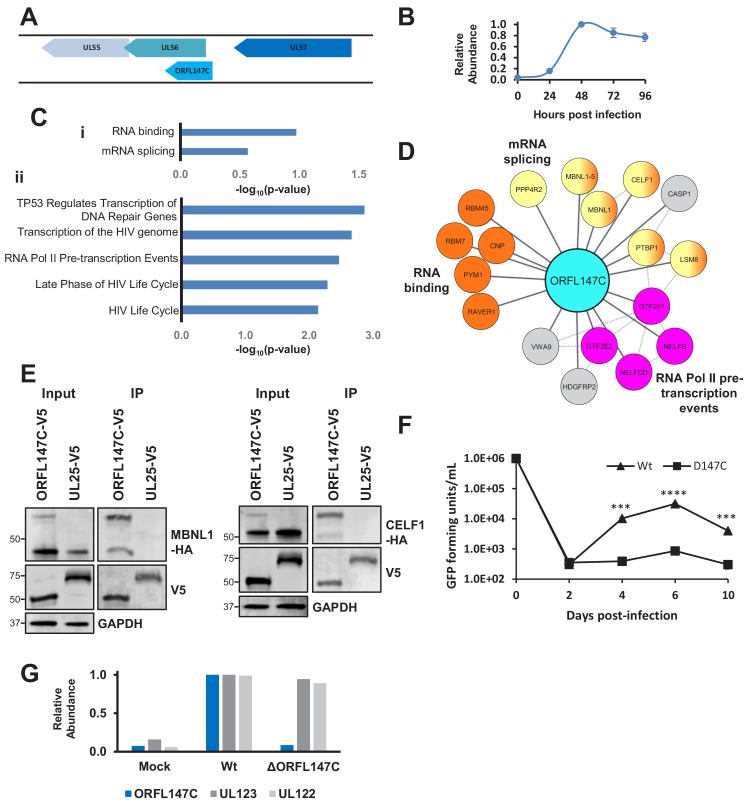
HCMV ORFL147C interactors function in RNA binding, splicing and transcription.(A) Diagram of the ORFL147C coding sequence and relation to neighbouring viral genes. (B) Expression kinetics of ORFL147C, taken from Weekes et al. (2014). Data was taken from experiments WCL2 and WCL3, enabling assessment of 24, 48, 72 and 96 hr time points in biological duplicate. Error bars show range. Mean expression was normalised to a maximum of 1. (C) Enrichment analysis of 80 human HCIPs interacting with ORFL147C. (i) DAVID analysis using all human proteins as background. Benjamini-Hochberg adjusted p-values are shown. (ii) Reactome database analysis (Fabregat et al., 2018) showing results with a minimum of 4 entities per enriched pathway. Full details of interacting proteins are given in Supplementary file 7A-B. (D) A subset of HCIPs for ORFL147C (full data are shown in Figure 6—figure supplement 1). Dashed lines represent human-human interactions derived from Bioplex 2.0 as described in Figure 2, in addition to known interactions that had been experimentally determined or derived from curated data as part of the STRING database. (E) Validation of interaction between ORFL147C and MBNL1 and CELF1 by co-IP, conducted as described in Figure 3. HEK293T cells were transiently transfected with the indicated plasmids, one expressing the C-terminally V5-tagged viral protein and the other expressing C-terminally HA-tagged MBNL1 or CELF1. These proteins were detected with anti-V5 and anti-HA. GAPDH – calnexin loading control. This figure is representative of n = 1 experiment. Expected sizes: MBNL1: 33–42 kDa; CELF1: 50–55 kDa; ORFL147C: 50 kDa; UL25: 74 kDa; GAPDH: 36 kDa. (F) Growth analysis of an ORFL147C-deficient recombinant. The ORFL147C and wild-type viruses were HCMV strain Merlin recombinants in which the enhanced GFP (eGFP) gene was cloned as a 3’-terminal fusion with immediate-early gene UL36, with a self-cleaving P2A peptide releasing the reporter following synthesis. Insertion of GFP does not impede UL36 function in such recombinants (Nightingale et al., 2018). Cells were infected at a MOI of 1, and supernatants harvested and titred every two days. Cells were infected in biological duplicates, and each supernatant was titred in technical duplicates. Mean values are shown, and error bars represent SD. p-values for a difference between wild-type and ORFL147C-deficient virus were estimated using a two-tailed Student’s t-test. ***p<0.001, ****p<0.0001. This figure is representative of n = 2 experiments. All data for this figure are also shown in Figure 6—source data 1. (G) ORFL147C protein is not expressed during infection with the ORFL147C-deficient recombinant (MOI = 2, 48 hr post infection). Viral protein expression was analysed using tandem mass tag-based proteomics as previously described (Nightingale et al., 2018). ORFL147C protein was measured at the same level as during mock infection in cells infected with the ORFL147C-deficient recombinant, attributable to noise. All data for this figure are also shown in Figure 6—source data 2.Figure 6—source data 1.Growth analysis of an ORFL147C-deficient recombinant.Figure 6—source data 2.Tandem mass tag-based proteomics analysis of ORFL147C protein expression.